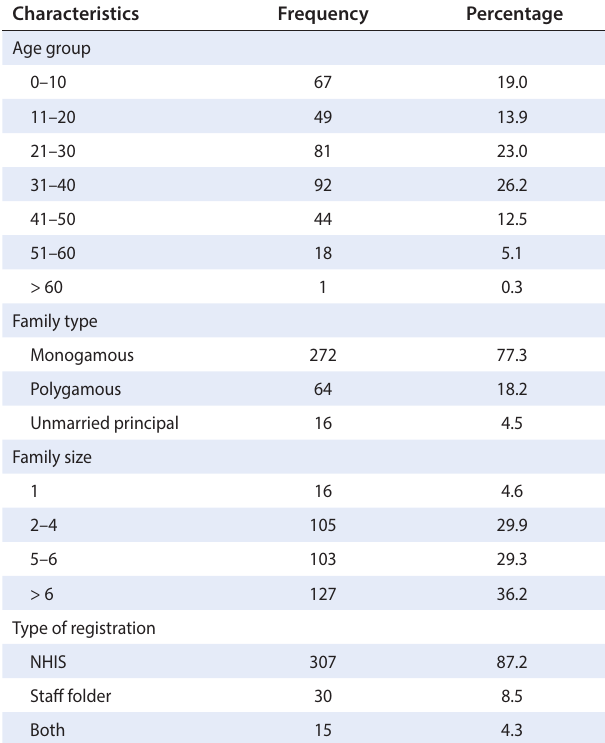
Table 1: Socio-demographic characteristics of study subjects Characteristics